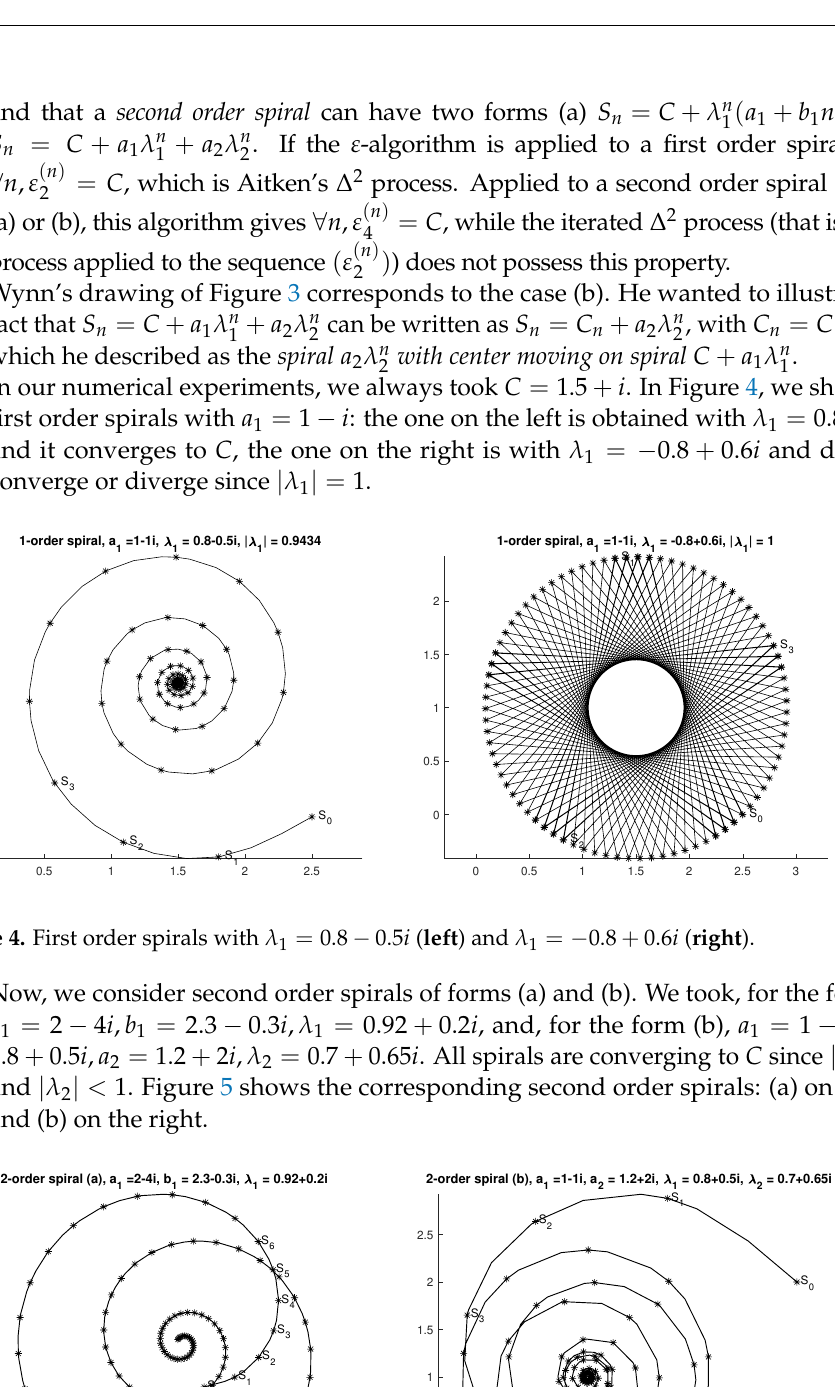
Figure 5. Second order spirals: (a) on the left and (b) on the right .